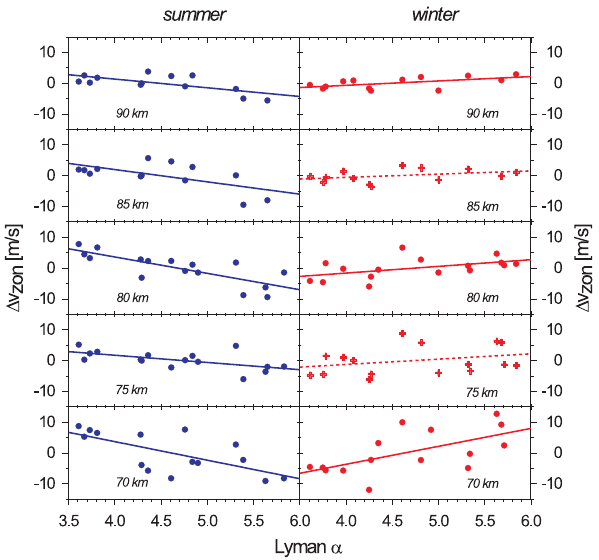
Fig. 7. Dependence of detrended zonal wind values at Juliusruh on solar activity for summer and winter conditions at different heights. Positive relations are red, negative relations blue. Significance lev- els are characterized by full lines and dots ( χ ≥ 95%), nonsignificant levels by dashed lines and crosses ( χ< 90%).